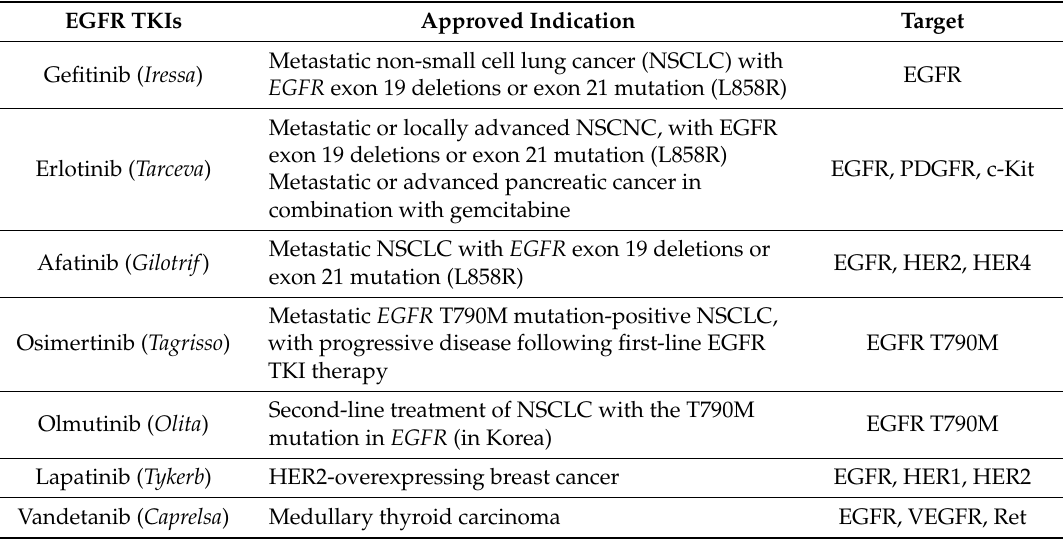
Table 1. Epidermal growth factor receptor (EGFR) tyrosine kinase inhibitors approved for cancer treatment.